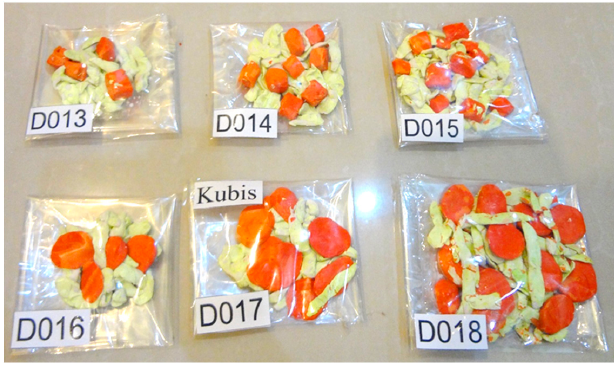
Figure 4. Food models for foodscapes preferences—shape criterion (for proteins).